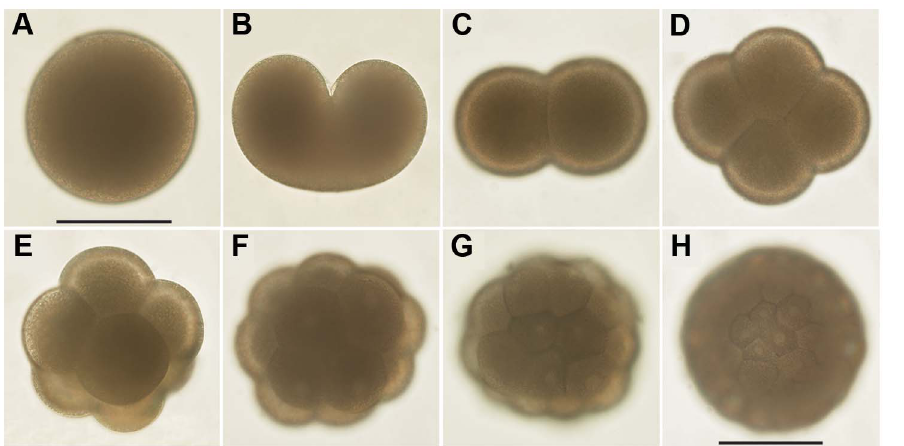
Figure 1. Compound microscope images of the embryo development of Lopheliapertusa . ( A ) oocyte; ( B ) 1 st cleavage; ( C ) 2-cell; ( D ) 4-cell; ( E ) 8-cell; ( F ) 16-cell morula; ( G ) 32-cell morula; ( H ) 64-cell blastula. First cleavage is equal and holoblastic, followed by radial cleavage. A slight shift of